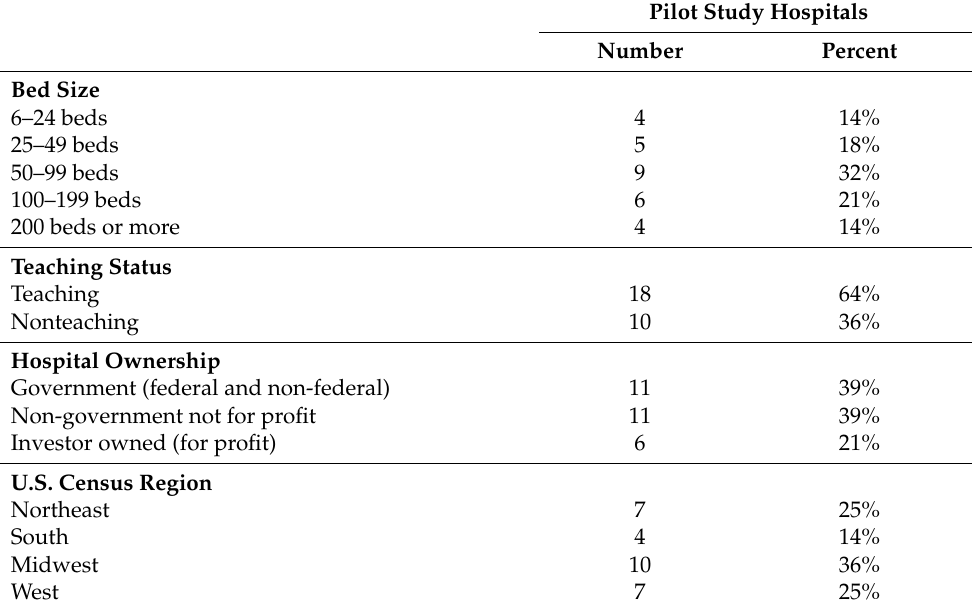
Table 3. Characteristics of pilot study hospitals ( N =